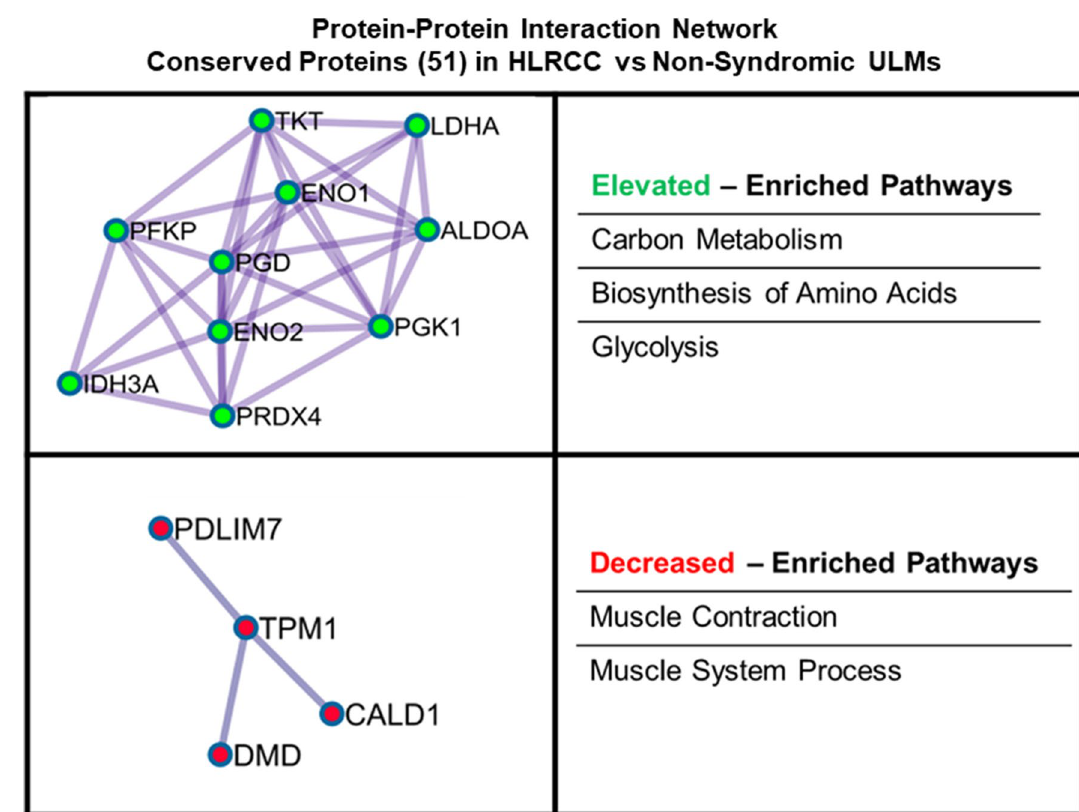
Figure 6. Protein interaction network enriched from validated transcripts confirmed at the protein-level as altered between HLRCC versus non-syndromic (NS) ULMs. Validated transcripts confirmed at the protein level (51 total) were analyzed using MetaScape 51 and resulting protein–protein interaction networks enriched by proteins elevated (highlighted in green) or decreased (heighted in red) in HLRCC vs NS ULMs were assembled using Cytoscape 52 . The top pathways enriched by network proteins are also